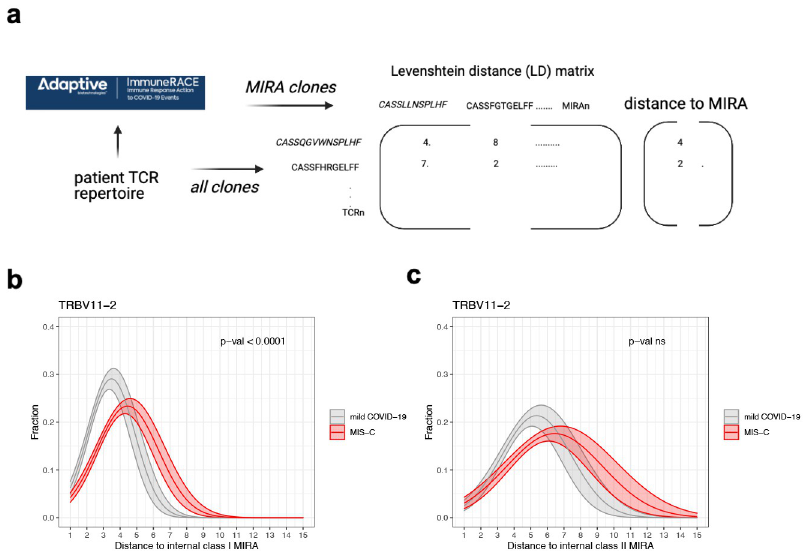
Fig 3. Distance to MIRA analysis. (a) Overview of distance to MIRA analysis: A distance matrix was constructed between all clones in a repertoire and those that mapped to the Adaptive MIRA database, and the distance to the closest MIRA clone was identified. (b) Distance to class I MIRA distribution of TRBV11-2 clones in the repertoires of children with mild COVID-19 or MIS-C. (c) Distance to class II MIRA distribution of TRBV11-2 clones in the repertoires of children with mild COVID-19 or